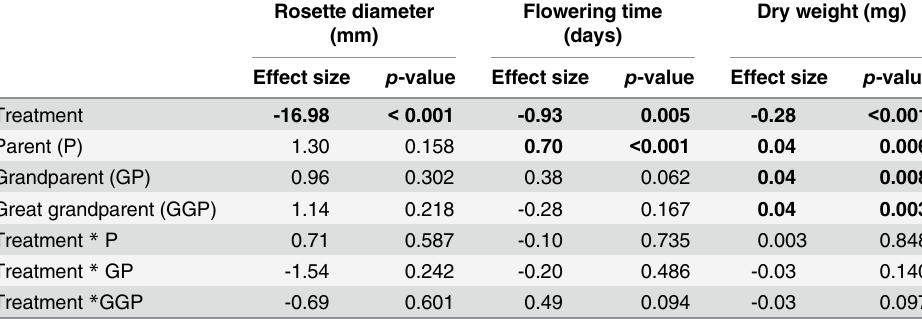
Table 3. Results of generalized linear mixed-effect model analysis of the climate chamber experiment, with (G.4) treatment (Control or Salt), parental history and the interaction between historic and test environment. Shown are unstandardized effect sizes and p -values, significant values are indicated in